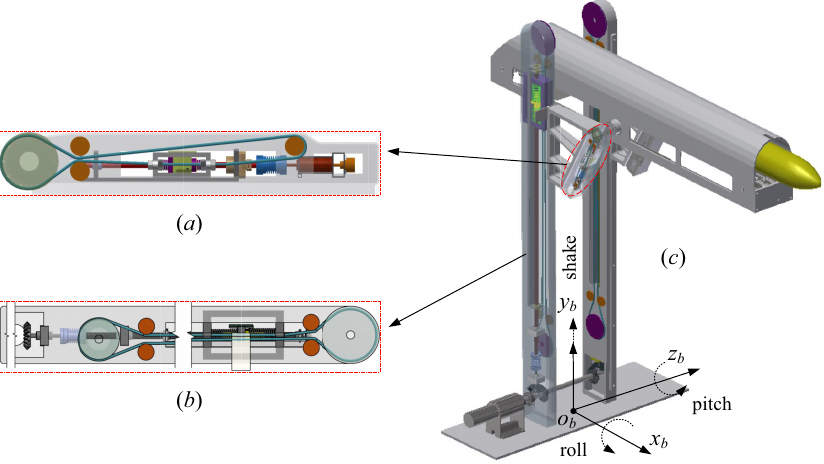
Figure 2. Virtual prototype of the novel ammunition transfer manipulator with SEAs. ( a ) is the SEA for the rotating part, ( b ) is the SEA for the lifiting part, and ( c ) is the manipulator subject to three base